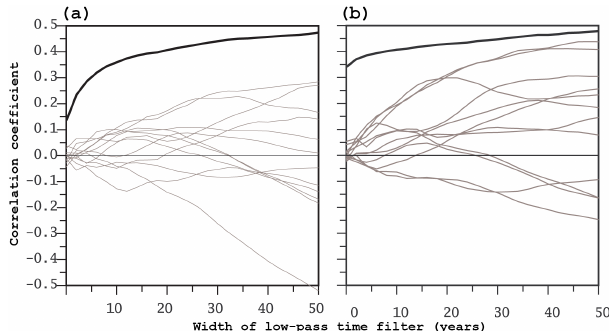
Figure 8. Correlations between the simulated upwelling indices in all four EBUSs in three past1000 simulations with the MPI-ESM model after filtering the time series with low-pass filter of increas- ing period (a) . The same as (a) but for the time series of sea level pressure difference between land and ocean averaged over the ar- eas most closely correlated with the simulated upwelling in this re- gion (b) . The 95 significance levels depend on which pair of series are being tested, since the test takes into account the serial corre- lation of each series. The figure shows, as an example, the signif- icance levels for the correlations r 1– r 2 for Benguela (bold black line), but all correlations shown here are not statistically significant at the 95% level.